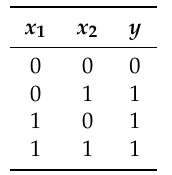
Table 3. Truth table for OR.